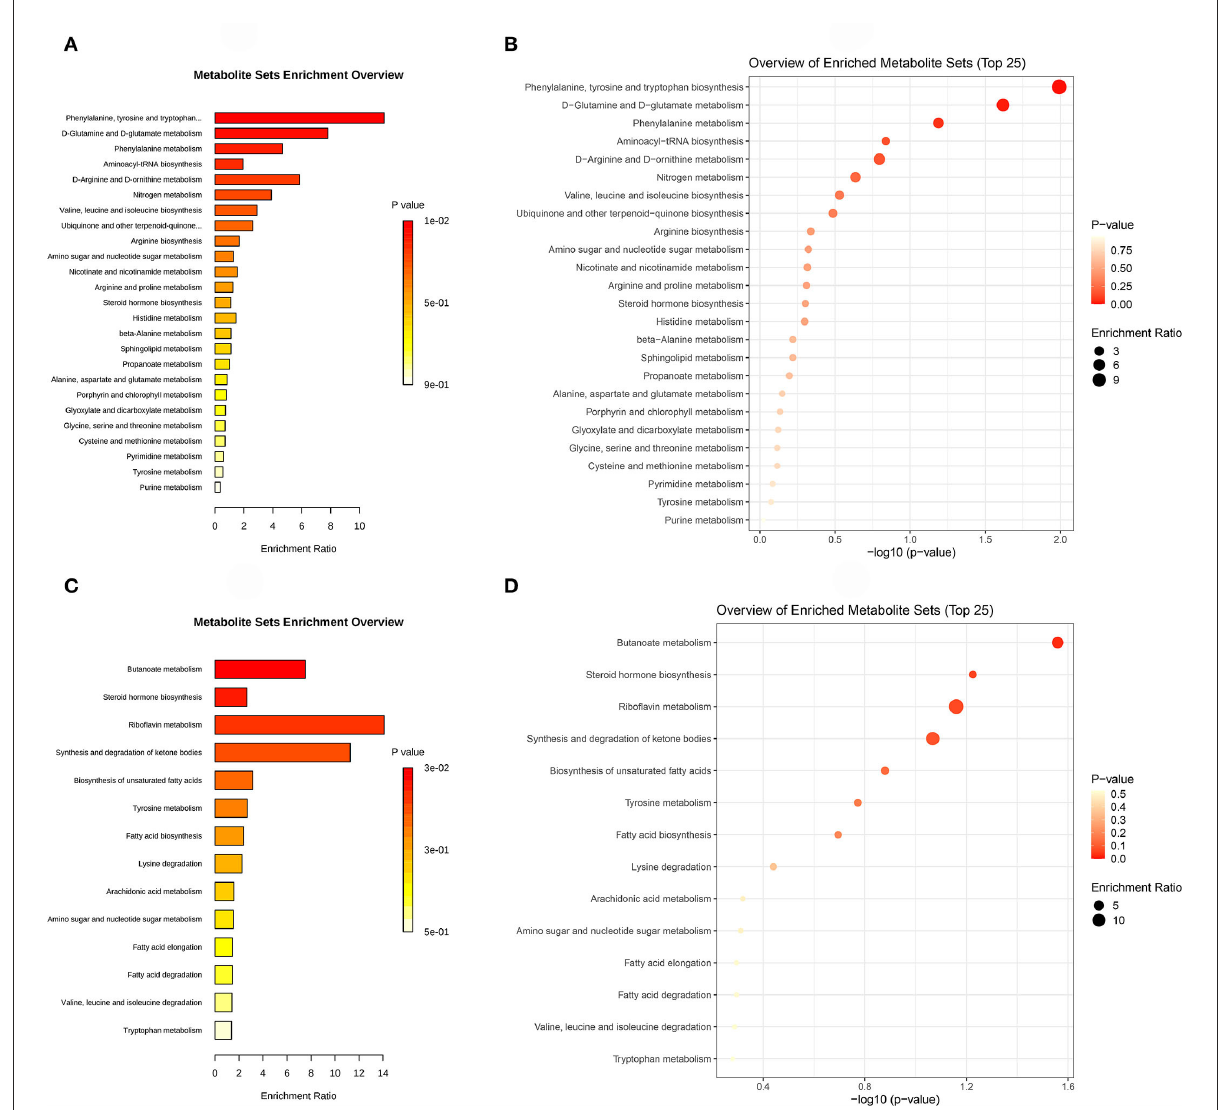
FIGURE6 (A) is the KEGG pathway column chart of the environmental factor group (DUvsG), and DUvsG refers to the group “Deep-underground vs. ground”; (B) is the KEGG pathway bubble chart of DUvsG; (C) is the KEGG pathway column chart of the sleep quality group (GSQvsPSQ), and GSQvsPSQ refers to the group “Good sleep quality vs. poor sleep quality”; (D) is the KEGG pathway bubble chart of GSQvsPSQ. Each bar or dot represents a KEGG pathway. The left ordinate denotes the pathway names, and the abscissa indicates the enrichment ratio or the negative logarithm to the base 10 of p -value. Specifically, enrichment ratio indicated the ratio of the differential metabolites annotated to this pathway to the metabolites annotated to a certain pathway by this species. The higher the enrichment rate, the more reliable the enrichment significance of differential metabolites in this